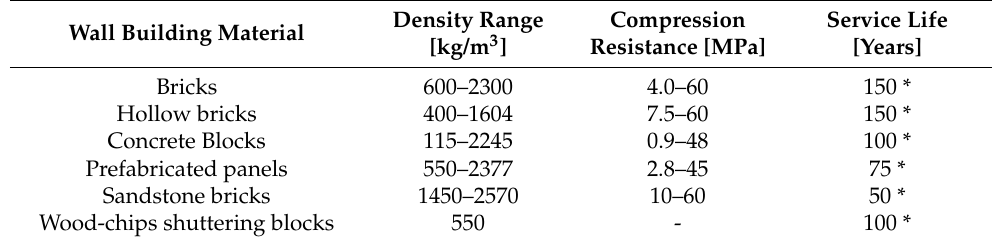
Table 5. Maximum and minimum value of the parameters characterizing the different products.